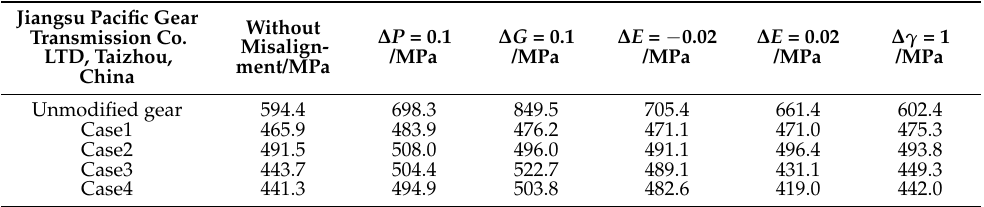
Table 4. Average values of the contact stress for the driving in single contact zone. Jiangsu Pacific Gear Transmission Co.